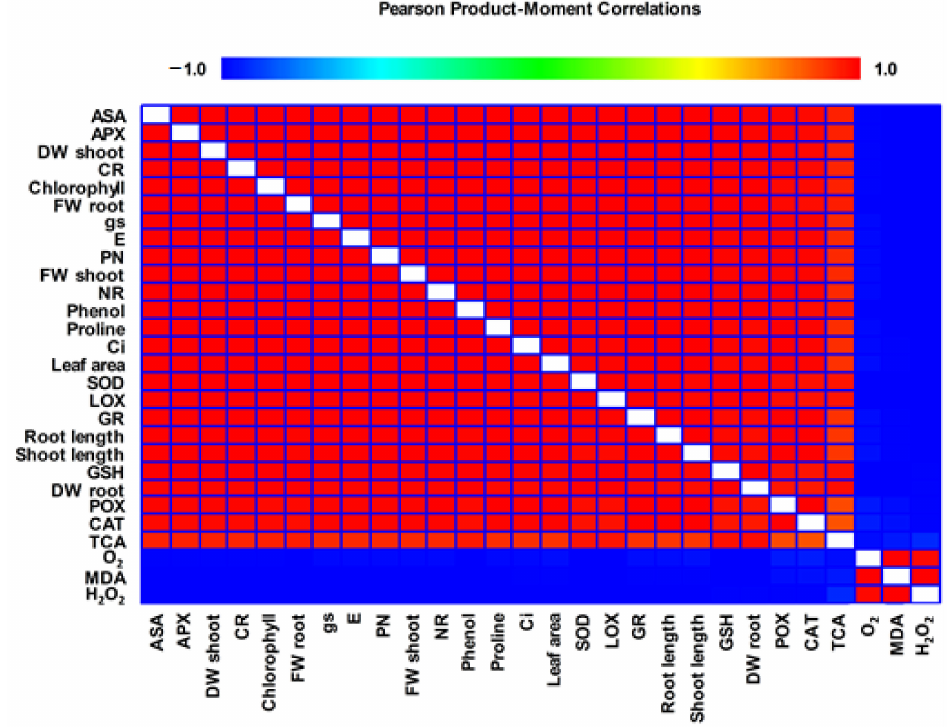
Figure 8. Heat map showing the correlation analysis under ToMV and treatments. The color scale displays the intensity of normalized mean values of different parameters. − 0.01 indicate to negative correlation, 0.01 indicate to positive